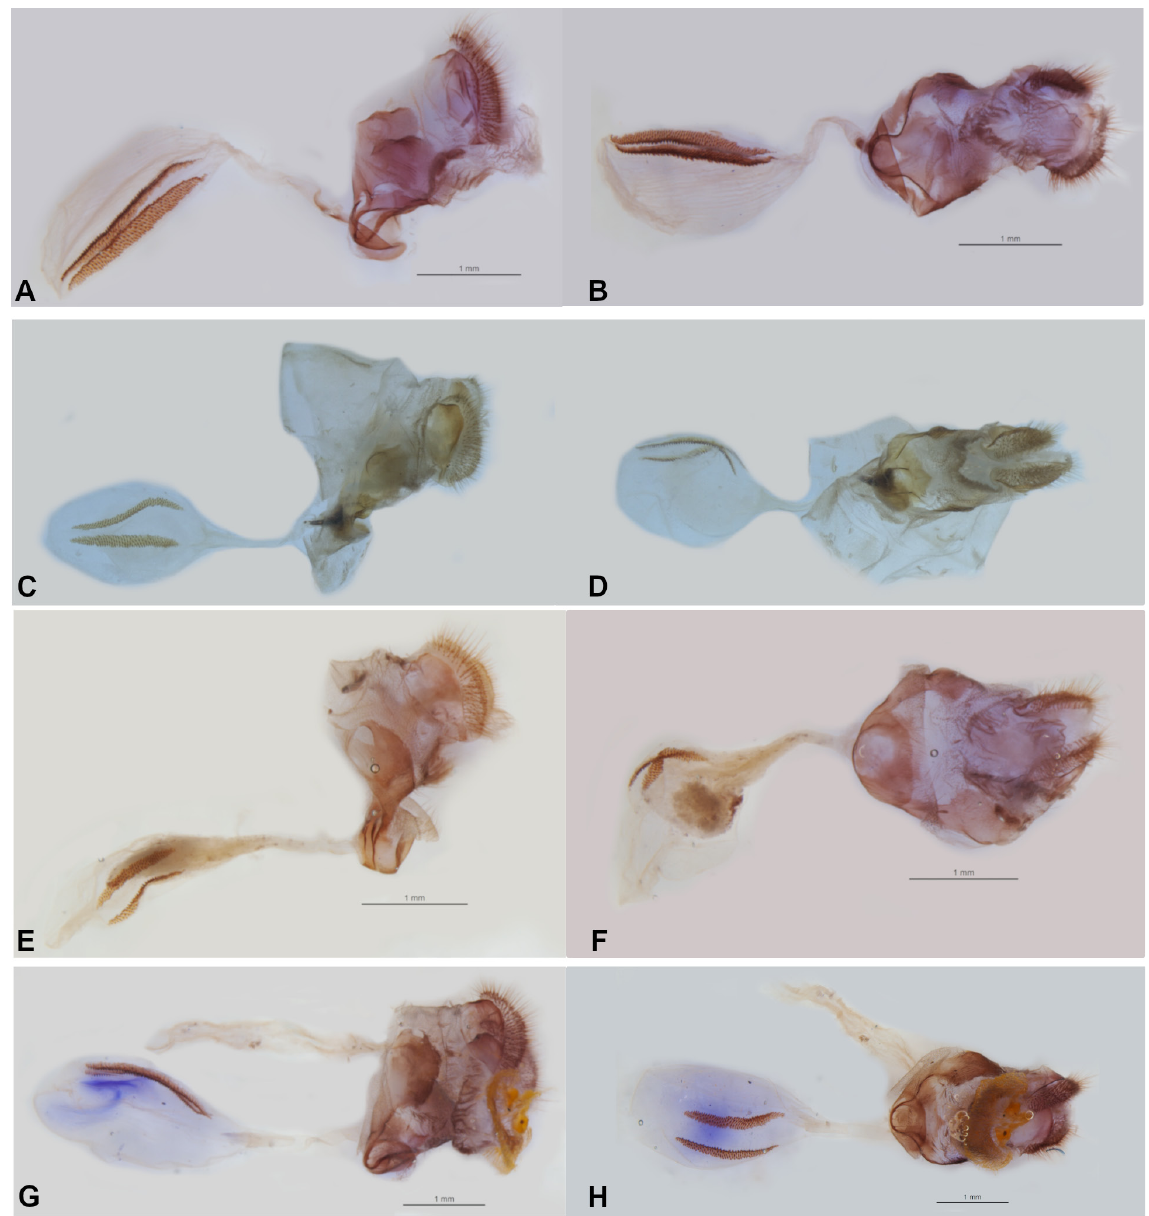
Fig. 7. Zischkaia “ saundersii clade”, female genitalia. A–B . Z. saundersii (Butler, 1867), ♀, lateral and ventral views (Genitalic vial: DZ 36. 969). C–D . Z. josti Nakahara & Kleckner, sp. nov., ♀, lateral and ventral views (Genitalic vial: 2018-002, D.J. Harvey). E–F . Z. mielkeorum Dolibaina, Dias & Zacca, sp. nov., ♀, lateral and ventral views (Genitalic vial: DZ 36. 688). G–H . Z. warreni Dias, Zacca & Dolibaina, sp. nov., ♀, lateral and ventral views (Genitalic vial: DZ 36.